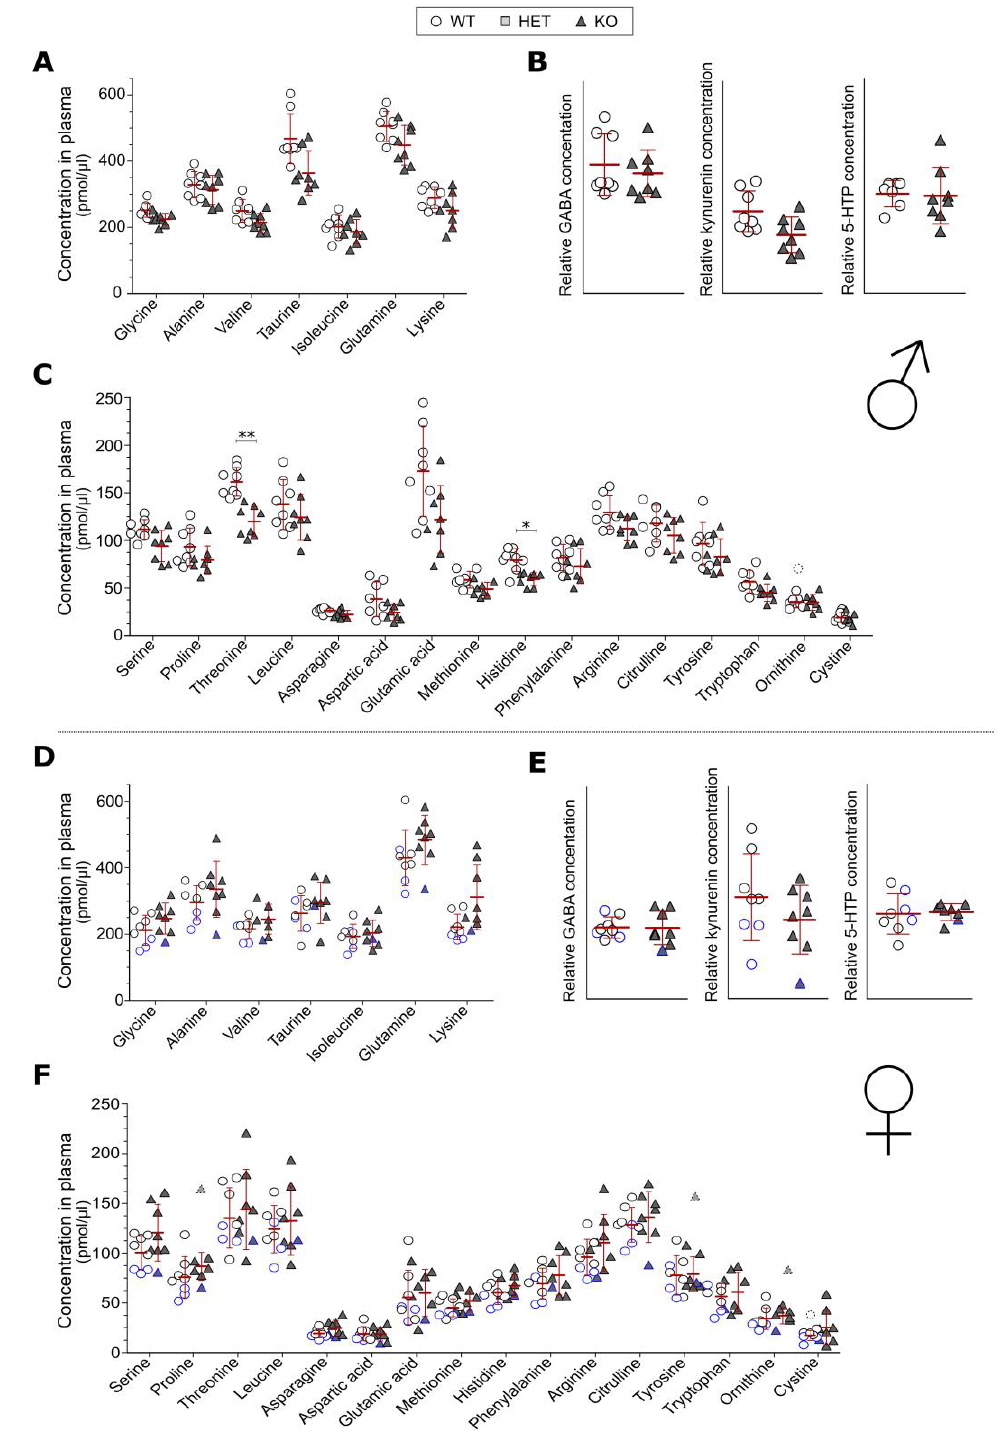
Figure 2. Amino acid levels in the plasma of SLC38A10 KO mice. Blood was collected from adult mice and the plasma was used for amino acid quantification. Amino acid levels were determined by LC-ESI-MSMS. Both ( A – C ) male (n = 7–8 WT, 8 KO) and ( D – F ) female (n = 7–8 per genotype) mice were used. Amino acids detected close to baseline are shown without absolute concentrations ( B , E ). Amino acid data were analyzed with unpaired t-tests with Bonferroni correction (adjusted p -value = 0.00197). Outliers (significantly different from the other data points according to Grubbs’ outlier test) were excluded from the analysis but plotted in the figure with dashed lines. Statistical differences between KO and WT mice are indicated with an asterisk sign (* p < 0.00197 and ** p <